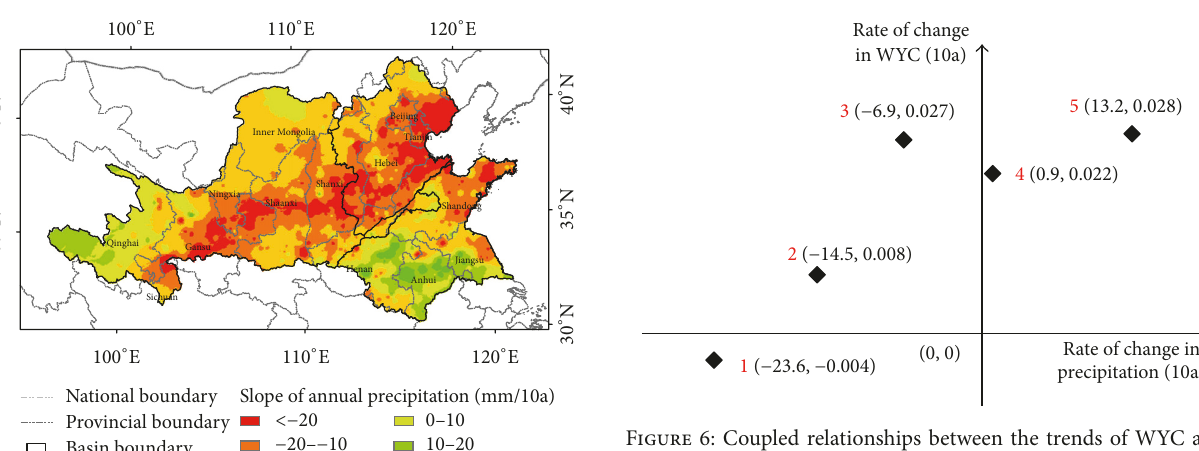
Figure 6: Coupled relationships between the trends of WYC and precipitation from 1961 to 2011.